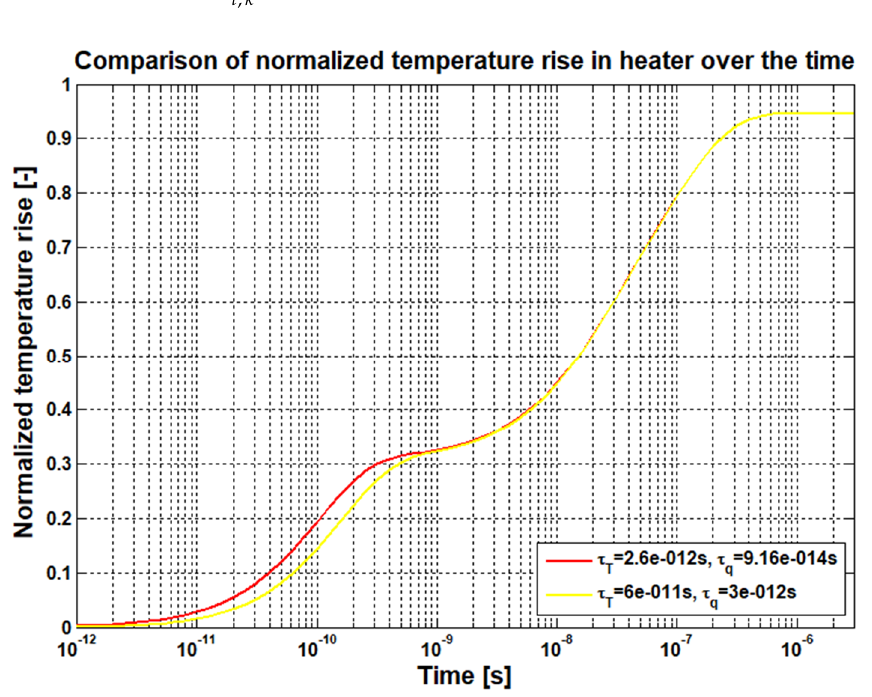
Figure 3. Average temperature rises over the time inside heat source (excluding investigation in Section 2.4).